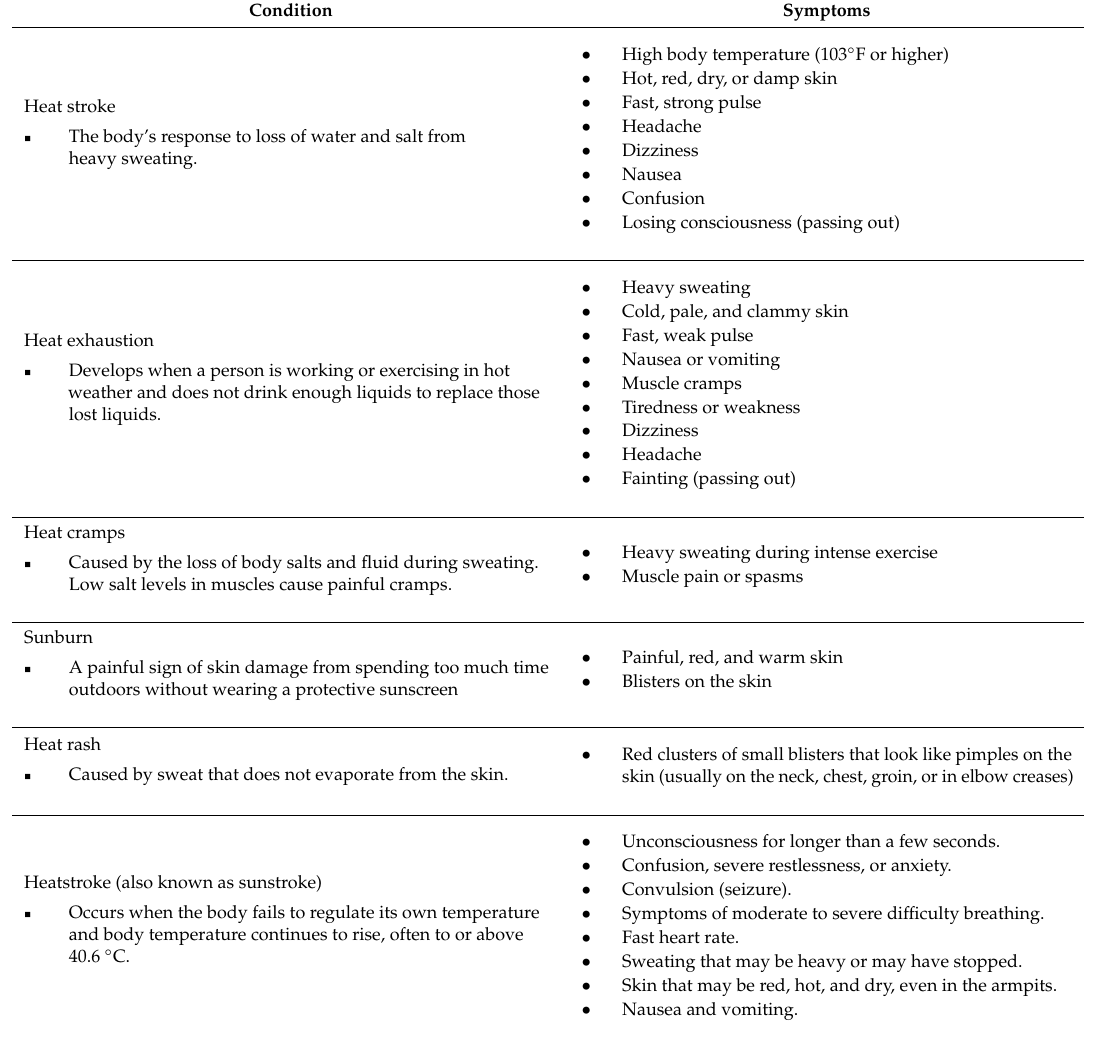
Table 1. Some heat related illnesses (condition and symptoms)—modified from the Centres for Disease Control (CDC).